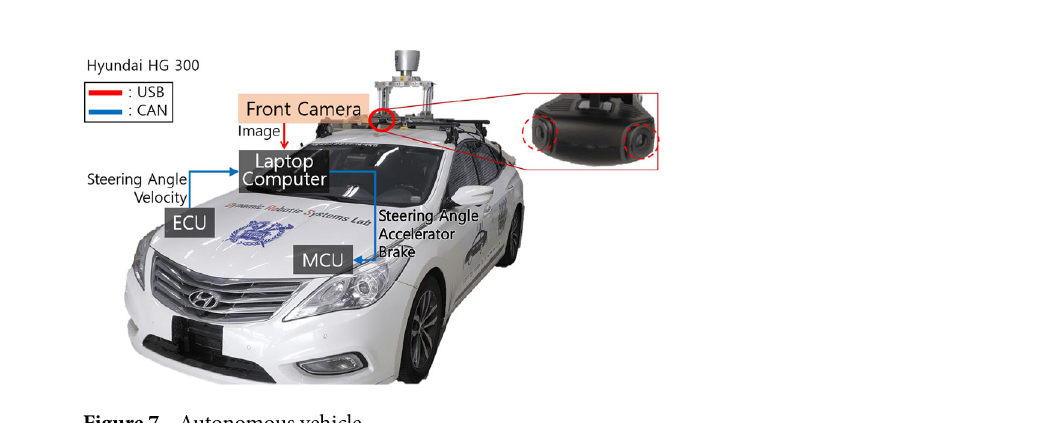
Figure 7. Autonomous